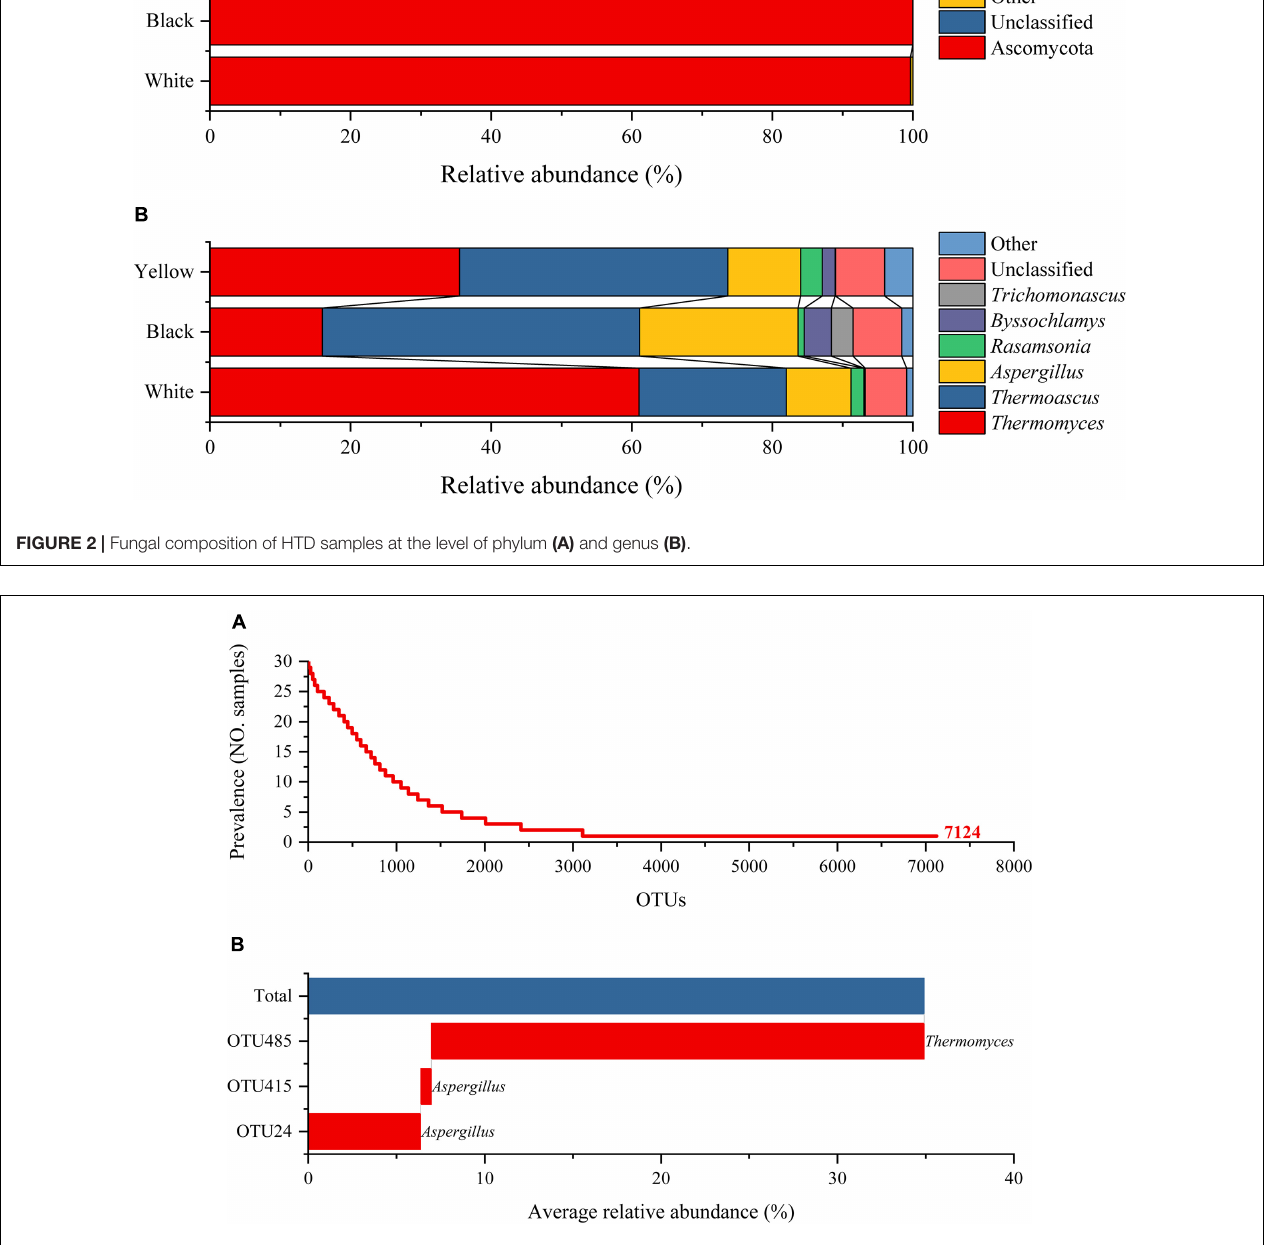
FIGURE 3 | Prevalence (A) and average relative abundance (B) of OTUs in HTD